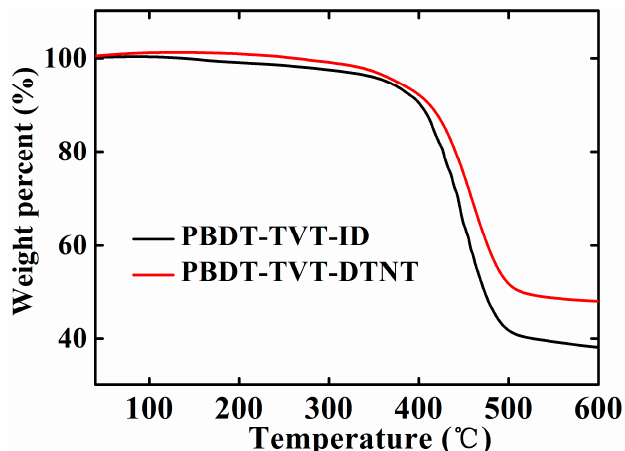
Figure 1. Thermal gravimetric analysis (TGA) characteristics of PBDT-TVT-ID and PBDT-TVT-DTNT.